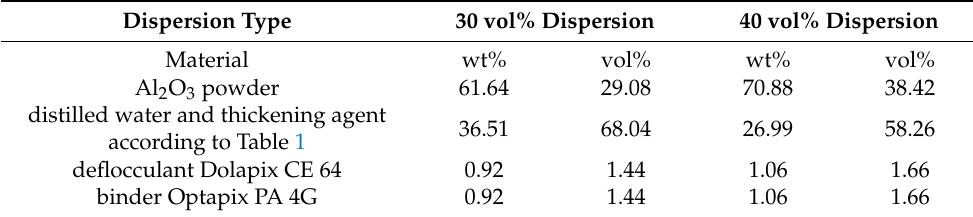
Table 3. Dispersion compositions for polyurethane (PU) foam